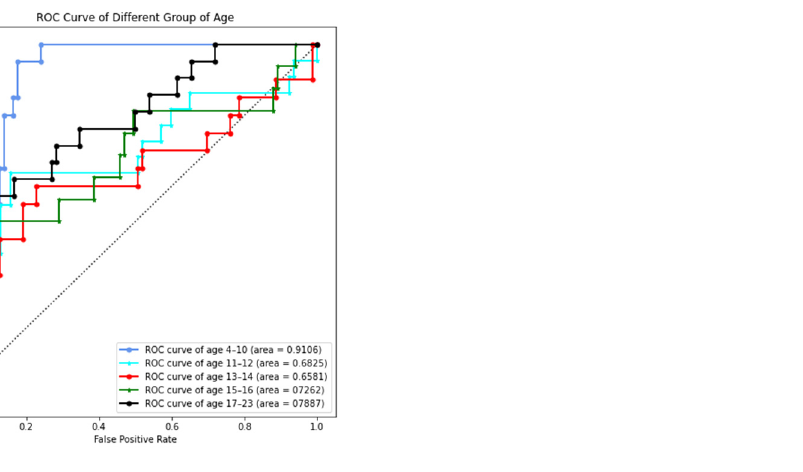
Figure 15. Receiver operating characteristic (ROC) curves and area under curve (AUC) values of different age ranges in the age range prediction model.